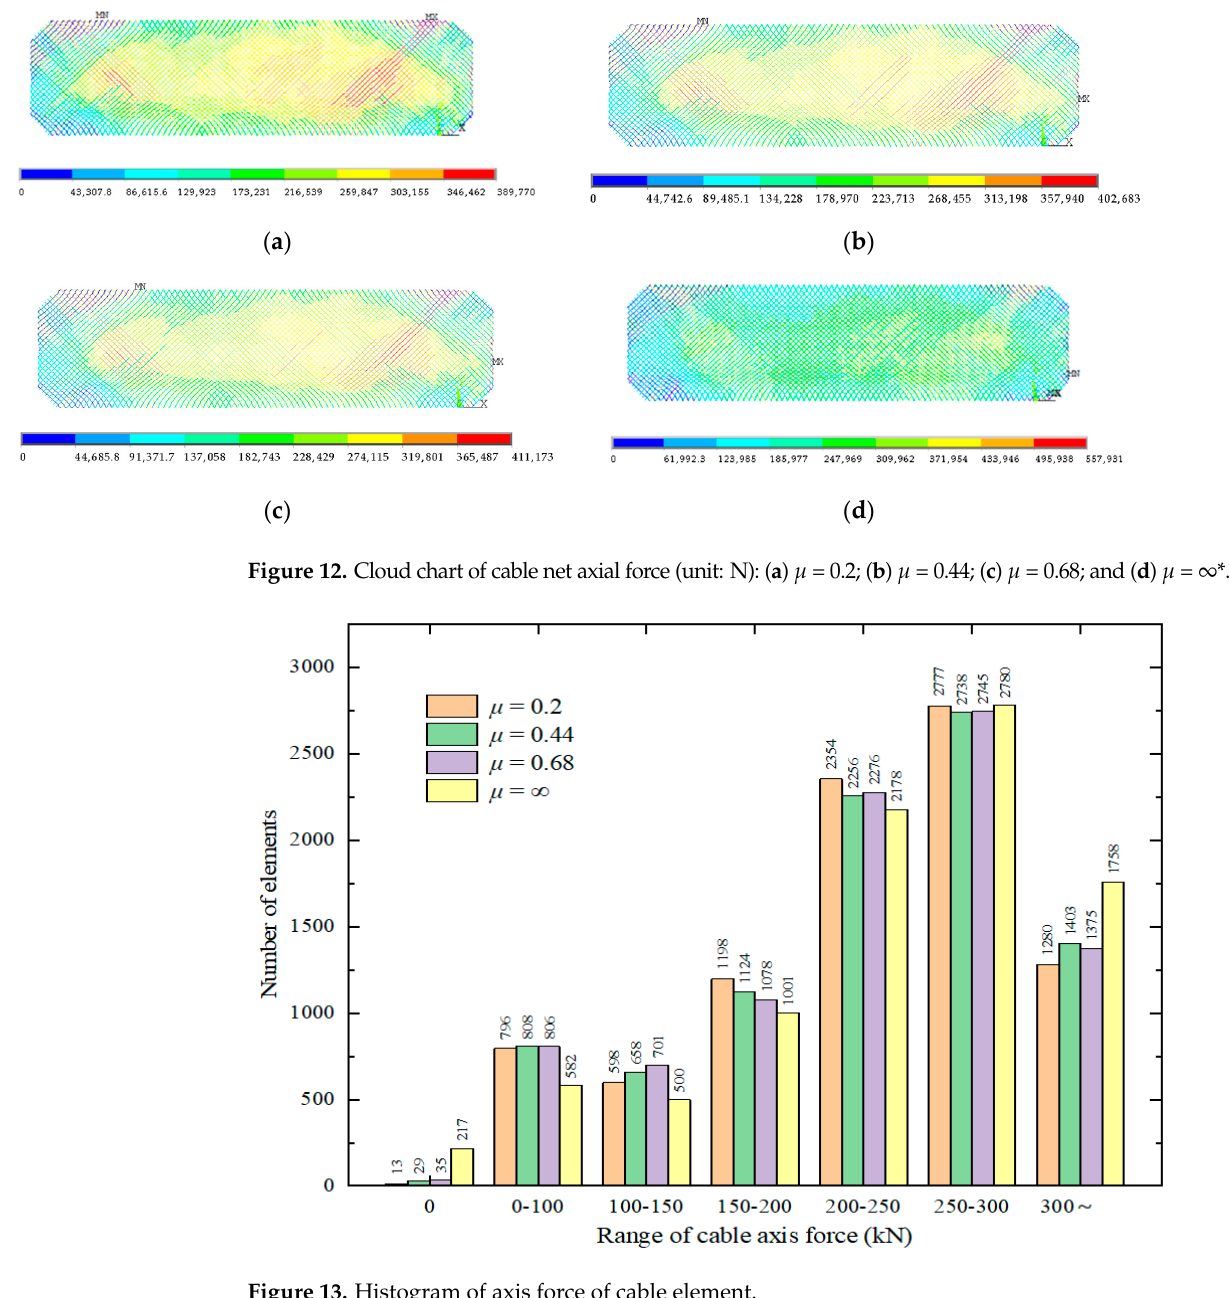
Figure 13. Histogram of axis force of cable